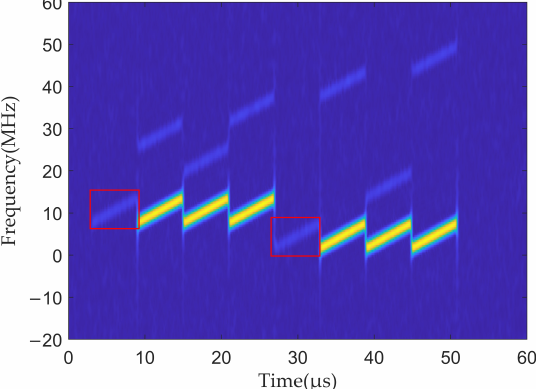
Figure 3. Time–frequency distribution of echo signal of intra-pulse frequency agile signal under